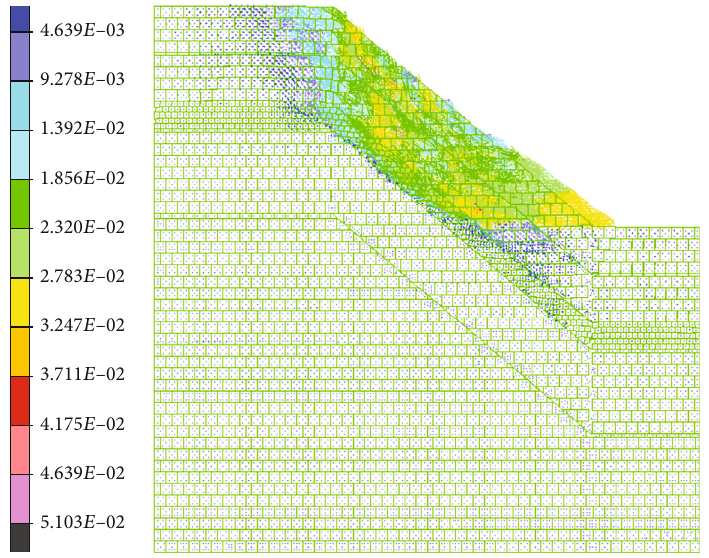
Figure 11: Speed vector diagram when running 80,000 steps.